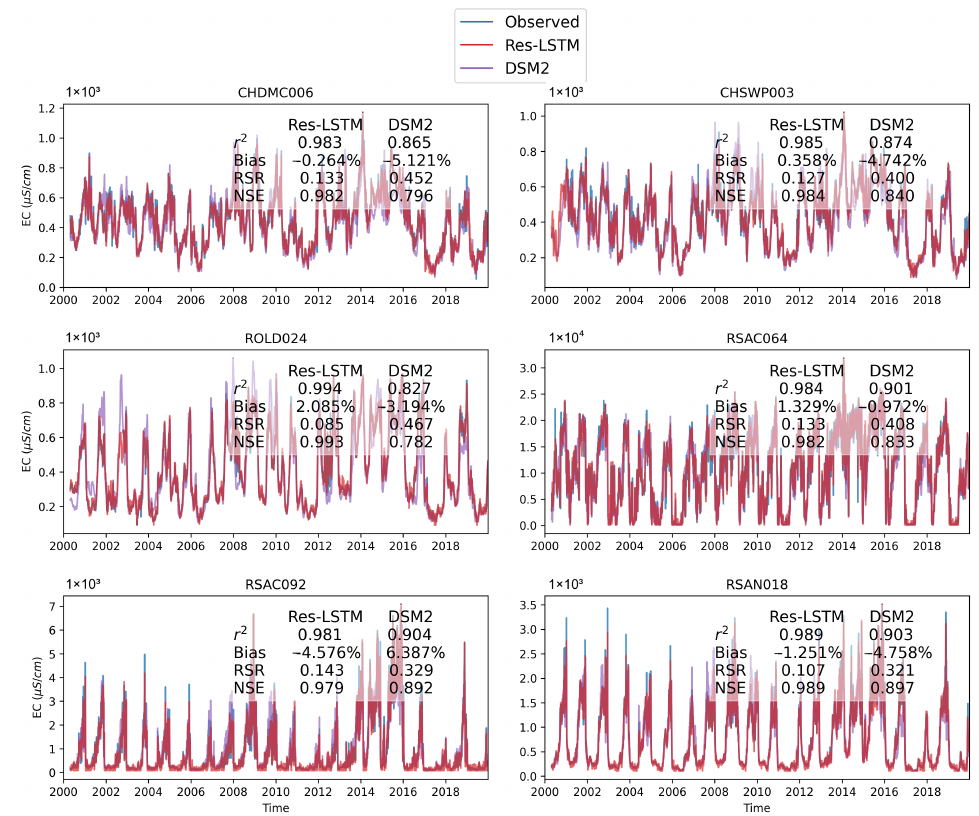
Figure 14. Time series plots of observed salinity levels versus Res-LSTM simulations and DSM2 simulations of six key stations. Detailed values of four evaluation metrics of Res-LSTM and DSM2 are marked for each